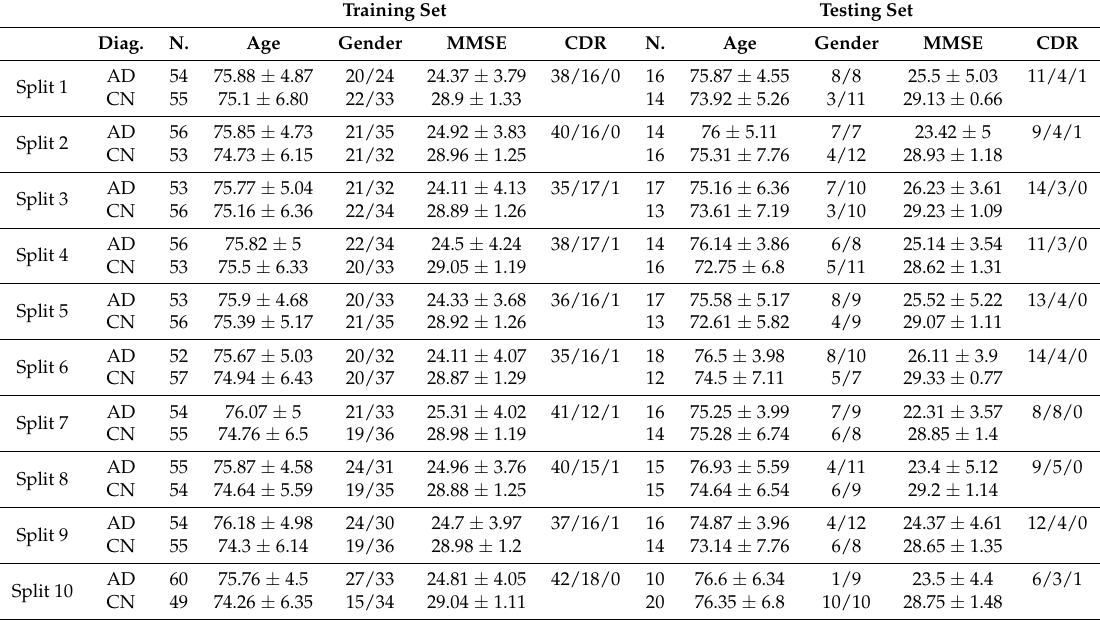
Table A2. Demographic information for each test split of the reduced dataset. Gender is indicated as male/female, the Clinical Dementia Rating scale (CDR) values are indicated as the number or patients diagnosed as very mild dementia/mild dementia/moderate dementia. Age and Mini-Mental State Examination (MMSE) values are indicated as mean ± standard deviation. Training Set Testing Set Diag. N.